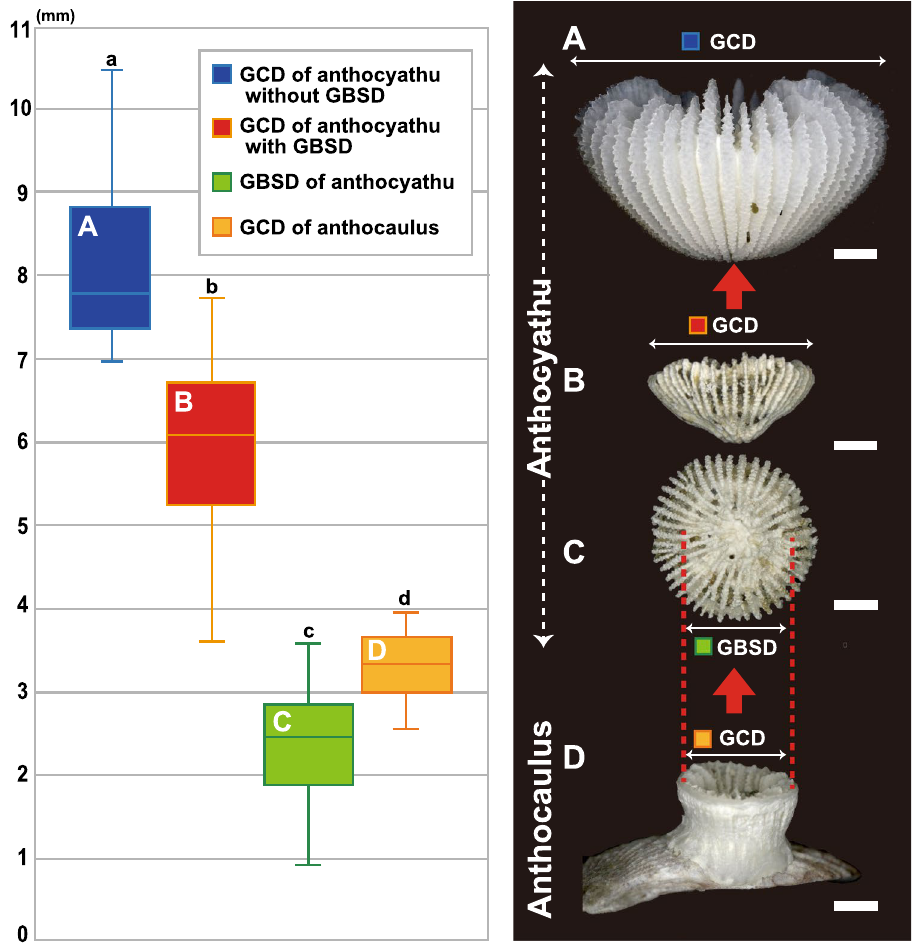
Figure 3. Box plots indicating the size distributions for the GCD of anthocyathi, GBSD, and GCD of the anthocauli for four abundance quartiles, and the photo characteristics measured for each specimen. The data are based on 41 specimens of anthocyathi and 11 specimens of anthocauli. The center line of each box plot represents the median abundance; the lower and upper edges of the boxes denote the 25th and 75th percentiles, respectively; and the whiskers denote the maximum and minimum percentiles. ( A ) Lateral views of GCD of anthocyathus without GBSD . ( B ) Lateral view of the GCD of anthocyathus with GBSD. ( C ) Bottom view of the GBSD of anthocyathus. ( D ) Lateral views of the GCD of anthocaulus (undescribed species). Scale bars = 1